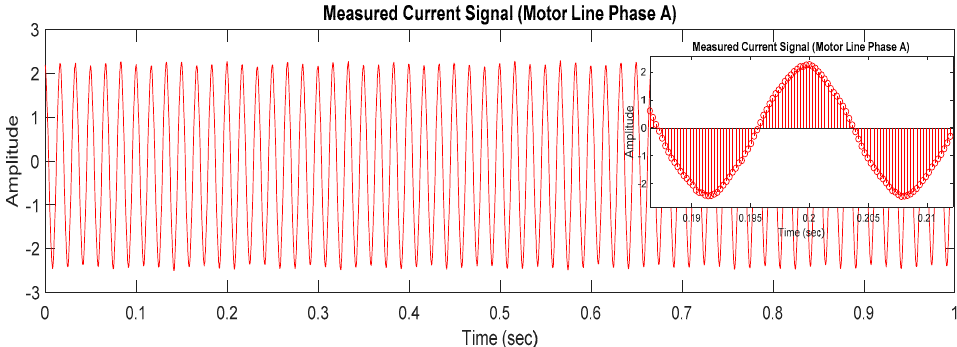
Figure 7. Current signal measurement of motor line current of phase A with a sampling frequency of 64 samples per cycle at 60 Hz with no VFD operation.